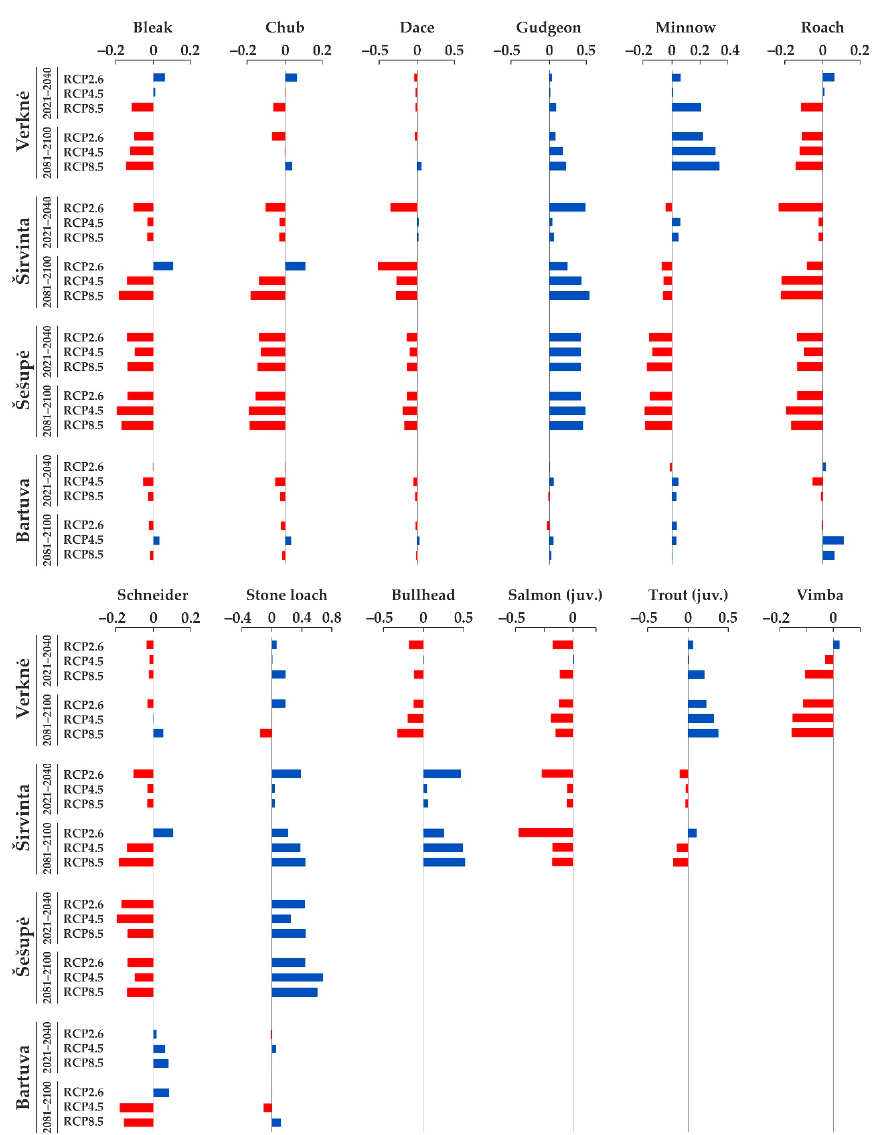
Figure 6. Deviation of the ITH of individual fish species from the average ITH of all fish species (set to 0.0) in the Verkn ė , Širvinta, Šešup ė , and Bartuva rivers according to different RCP scenarios for the periods 2021–2040 and 2081–2100.